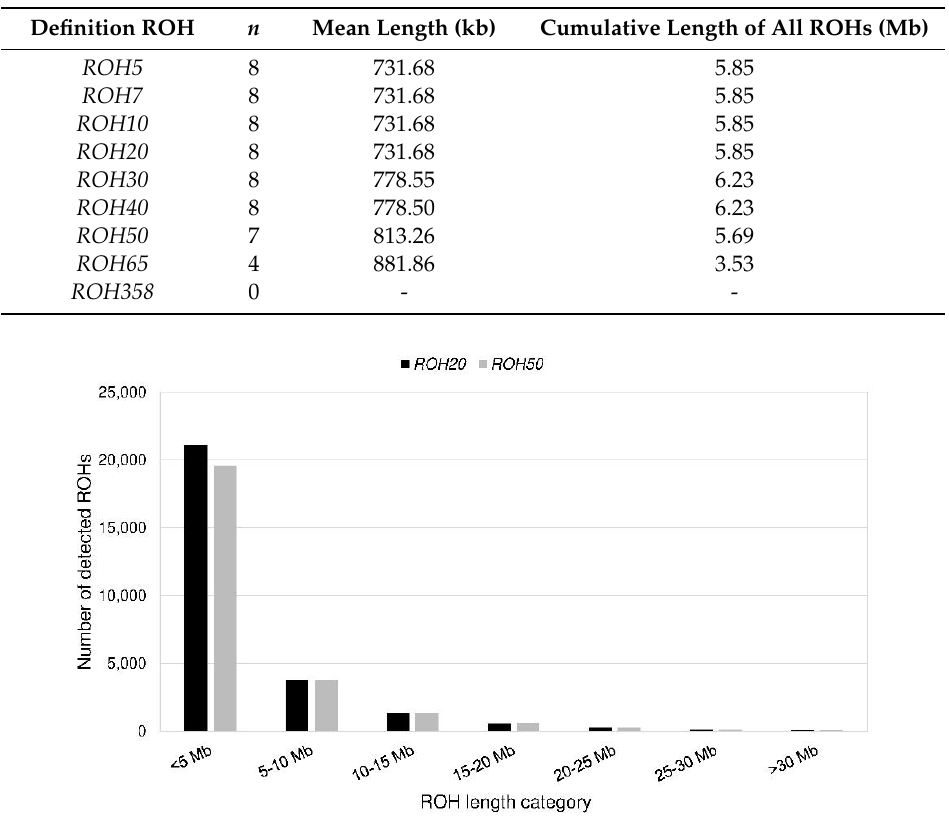
Figure 5. Number of detected runs of homozygosity (ROHs) per length category for ROH20 and ROH50 .